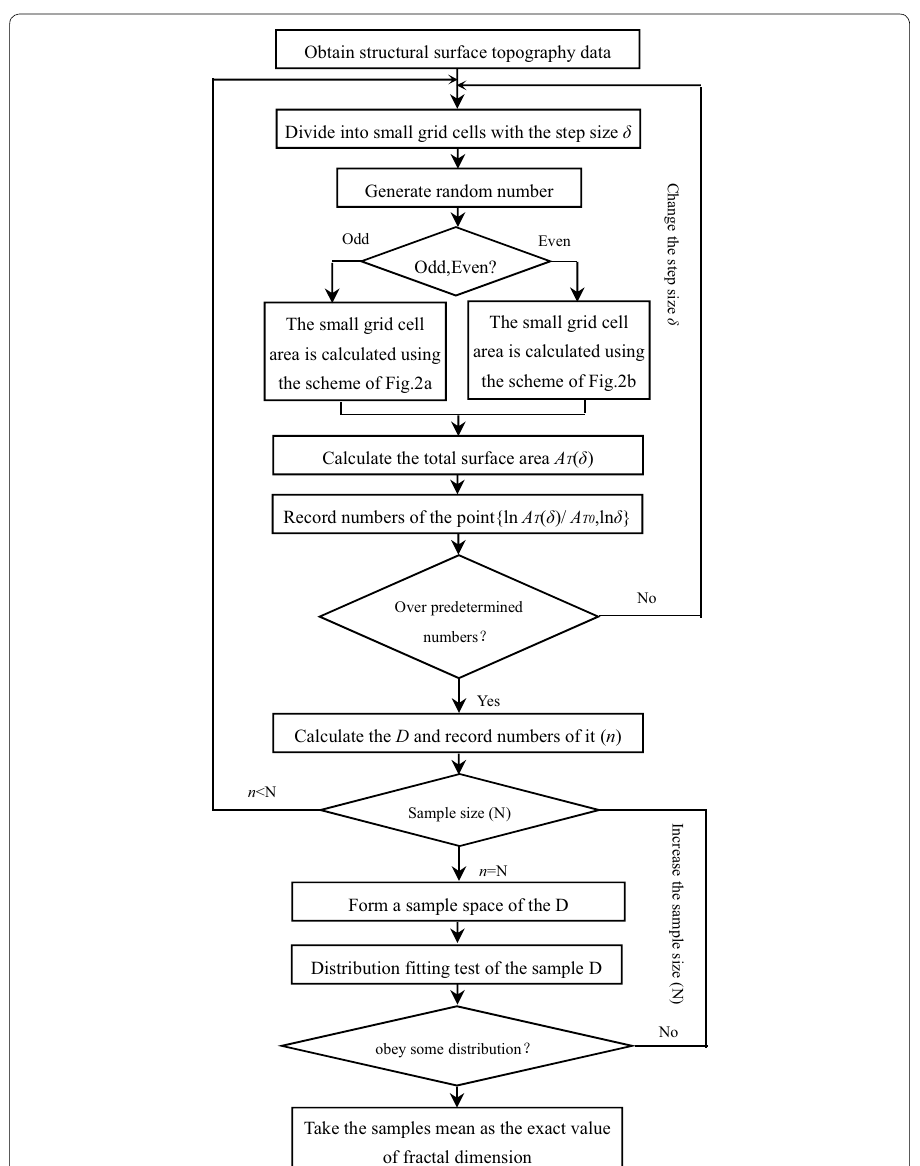
Fig. 3 Design procedure of IPCM